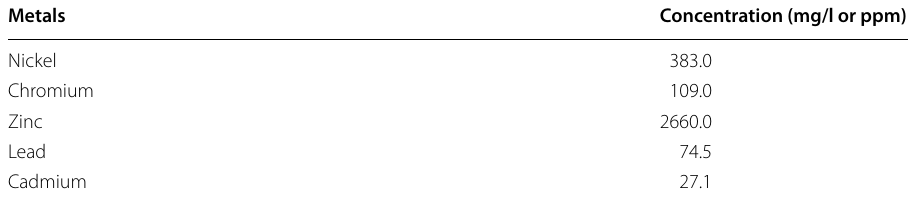
Table 2 Heavy metal concentration in dredged soil